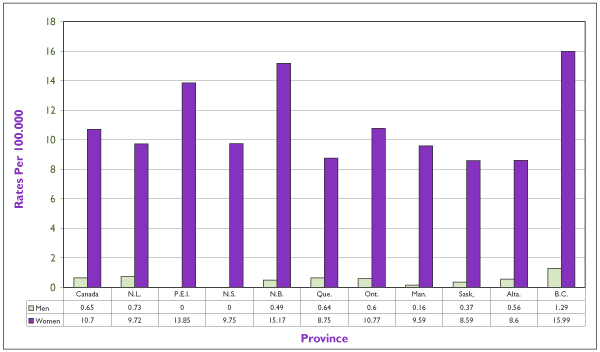
Inpatient Crude Hospital Separation Rates per 100,000 for Anorexia, Bulimia and Eating Disorder Not Otherwise Specified by Canadian Province, 1994–1999 Source: Canadian Institute for Health Information